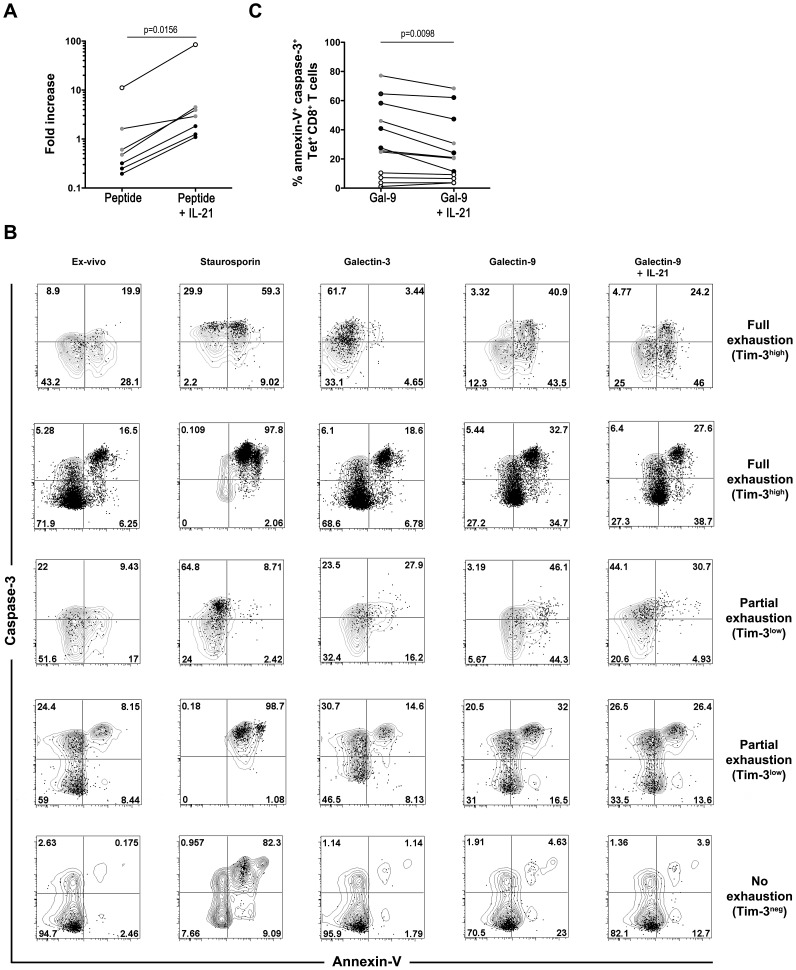
IL-21 enhances proliferation and limits Galectin-9 induced apoptosis in Tim-3high HCV-specific CD8 T cells.(A) IL-21 enhances expansion of HCV-specific CD8 T cells in a Tim-3-dependent manner. PBMCs from acute HCV patients were stimulated with their cognate peptide epitopes corresponding to the HCV MHC class I tetramers used, in the presence or absence of IL-21. Patients were classified according to Tim-3 expression on HCV tetramer+ CD8+ T cells as: Tim-3neg (open circles), Tim-3low (grey circles) and Tim-3high (closed circles). Fold expansion was calculated by dividing the frequency of HCV tetramer+ CD8+ T cells after in vitro expansion by the frequency measured directly ex vivo. P-values were calculated using Wilcoxon signed rank test. (B) IL-21 counteracts Galectin-9-induced apoptosis. PBMCs were incubated for 4 hours in the presence of Staurosporin (1 µM), a protein kinase C (PKC) inhibitor (used as a positive control for induction of apoptosis), Gal-3 (negative control) or Gal-9 (1 µM), in the presence or absence of IL-21. Cells were then stained with HCV tetramers and antibodies against cell surface markers. Apoptosis was measured by surface staining with Annexin V followed by fixation and permeabilization, before intracellular staining for caspase-3. Representative data of PBMCs from patients during acute HCV expressing high (top), low (middle) or negative (bottom) levels of Tim-3 on the surface of HCV-tetramer+ CD8 T cells and corresponding to different levels of exhaustion as described in Figure 3 (n = 2 for full exhaustion, n = 2 for partial exhaustion, and n = 1 for no exhaustion). Patients tested were all in the early acute phase (day 22–124). (C) IL-21 counteracts Galectin-9-induced apoptosis of HCV-specific CD8 T cells. Gal-9-induced apoptosis in the presence or absence of IL-21 was measured by the co-expression of caspase-3 and Annexin V on HCV-specific tetramer+ CD8 T cells expressing different levels of Tim-3 during early acute HCV infection (day 22–124) (n = 12) as described in Figure 6B. Tim-3neg (open circles), Tim-3low (grey circles) and Tim-3high (closed circles). P-values were calculated using Wilcoxon signed rank test.